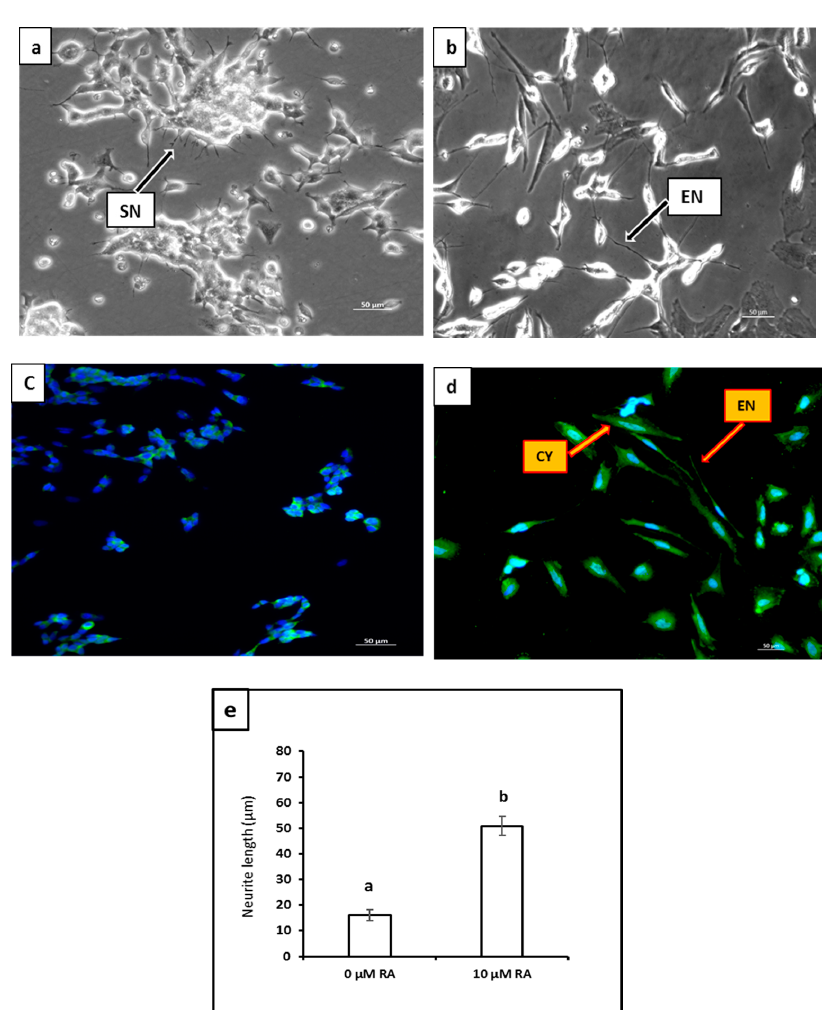
Figure 2. Fluorescence microscopy to confirm the differentiation process of human neuroblastoma (SH-SY5Y) cells. ( a ) Phase contrast of undifferentiated cells maintained in complete growth media. ( b ) Phase contrast of differentiated cells cultured in complete growth media treated with 10 µM of retinoic acid (RA). ( c ) Fluorescence micrograph of undifferentiated cells cultured in complete growth media and stained with 4 ′ ,6-Diamidine-2 ′ -phenylindole dihydrochloride (DAPI). ( d ) Fluorescence micrograph of differentiated cells cultured in complete growth media treated with 10 µM of RA and stained with DAPI, increases in green fluorescent intensity indicated highly expressed tuj-1 in both cytoplasm and neurites. CY = cytoplasm, EN = extended neurites, SN = short neurites. Magnification (× 20). ( e ) Neurite length in undifferentiated (0 µM RA-treated) and differentiated (10 µM RA-treated) SH-SY5Y cells after 7 days of differentiation. Data are displayed as means ± SD of triplicate experiments; means with different letters denote significant difference ( p < 0.05).